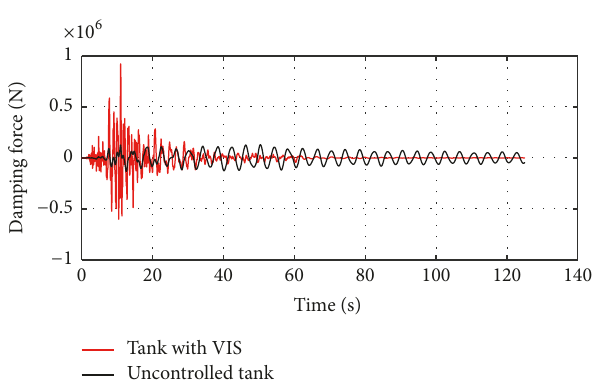
Figure 18: Output forces of the tank with the VIS and the uncontrolled tank under the excitation of the Coalinga earthquake.